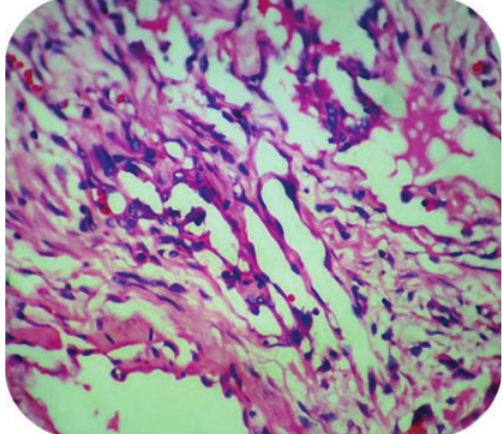
Figure 6: Dermis shows thin-walled vascular channels lined by endothelial cells showing mild atypia. Small papillary projections are seen (Case 2—H&E ×